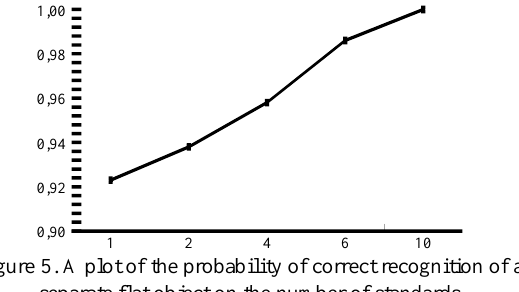
106421 Figure 5. A plot of the probability of correct recognition of a separate flat object on the number of standards